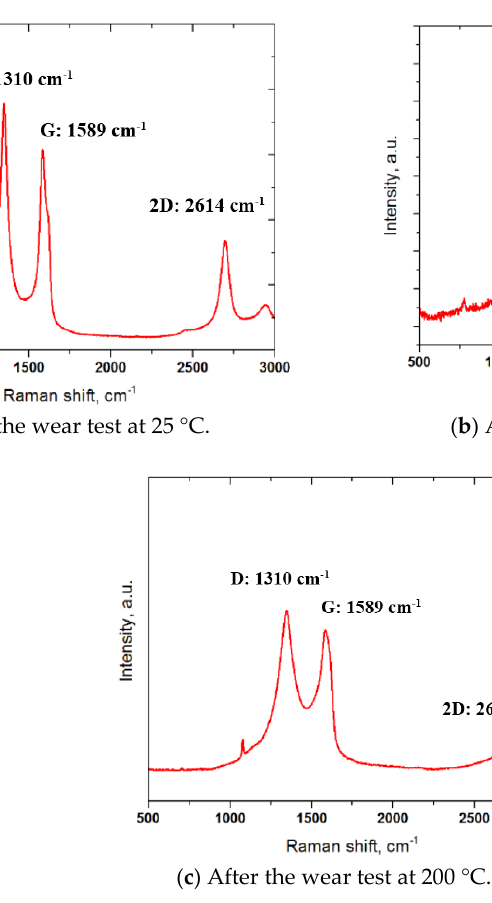
Figure 13. Raman spectra obtained from wear track formed on the surface of the C/C-SiC composite slid against AISI52100 steel at temperatures 25, 100 and 200 °C.